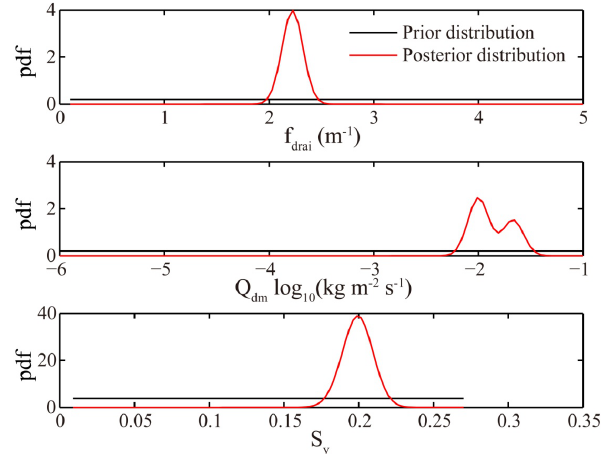
Figure 9. Posterior distribution of the reduced parameter set from previous sensitivity analysis at 821 Fig. 9. Posterior distribution of the reduced parameter set from pre- vious sensitivity analysis at the US-MOz site. the US-MOz site, with a reference acceptance probability of 1.0. 822